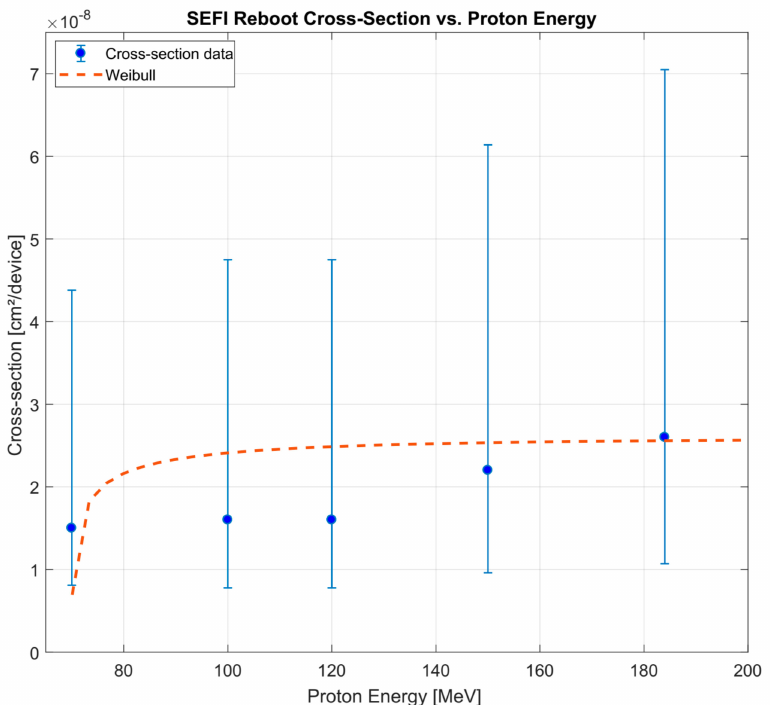
Figure 10. Cross-section for the SEFI reboot events vs. proton energy (E th = 70 Mev, W = 1.24, S = 0.439). Error bars are Poisson errors at 90% confidence